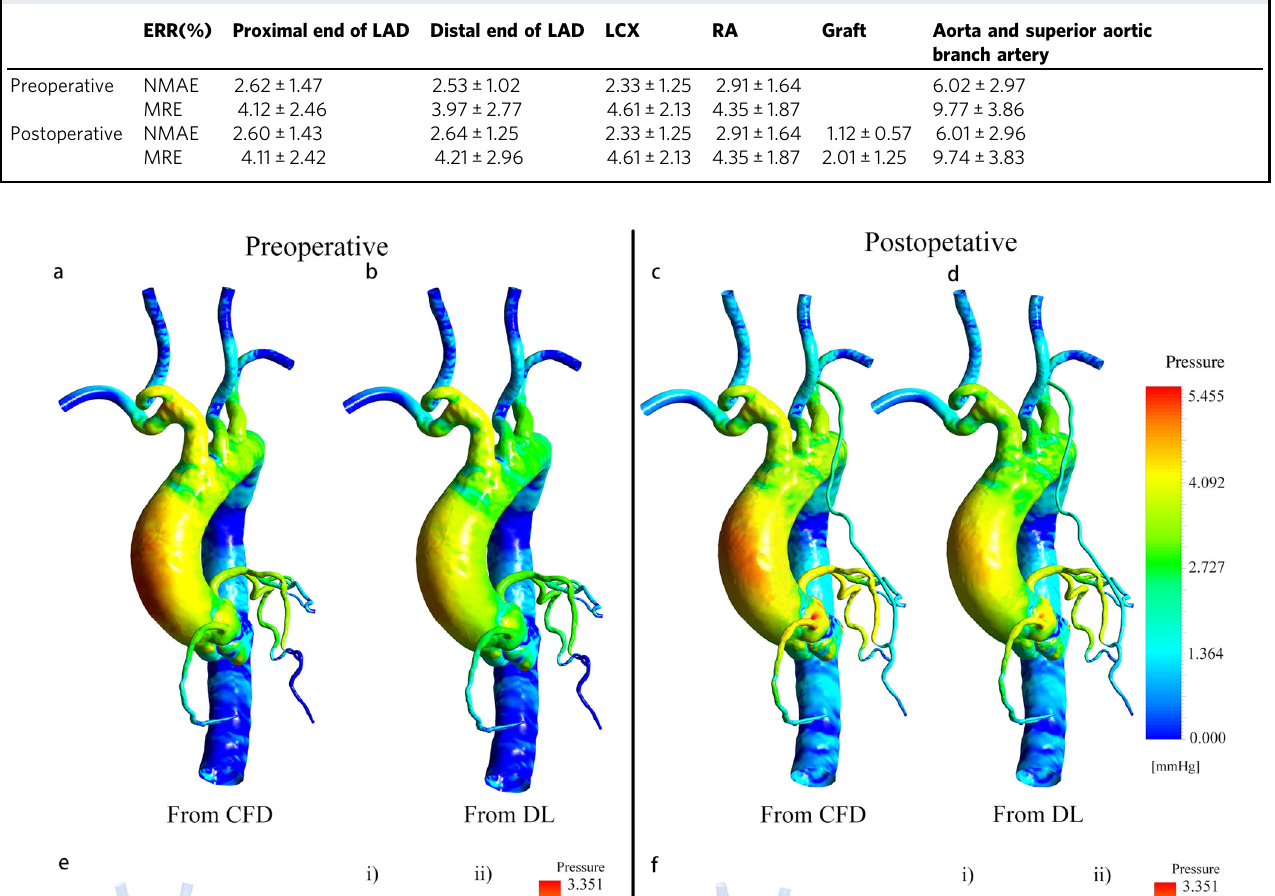
Table 1 Performance evaluation of the velocity fi eld.